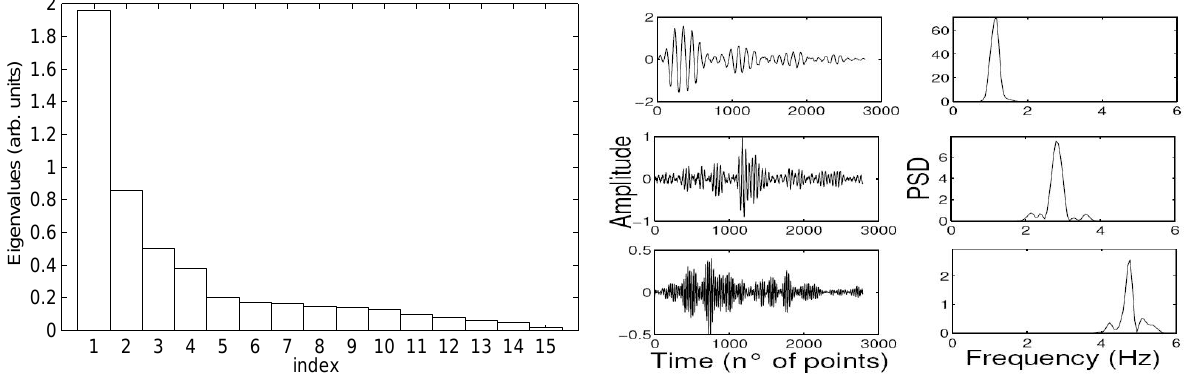
Fig. 3. Strombolian explosion-quakes in the higher frequency band ( f > 0 . 5Hz). Left panel: PCA results. A few principal components contain essentially all the dynamically relevant information. Right panels: ICA results. Only three components are independent with a specific and well-defined spectral content (from Acernese et al.,